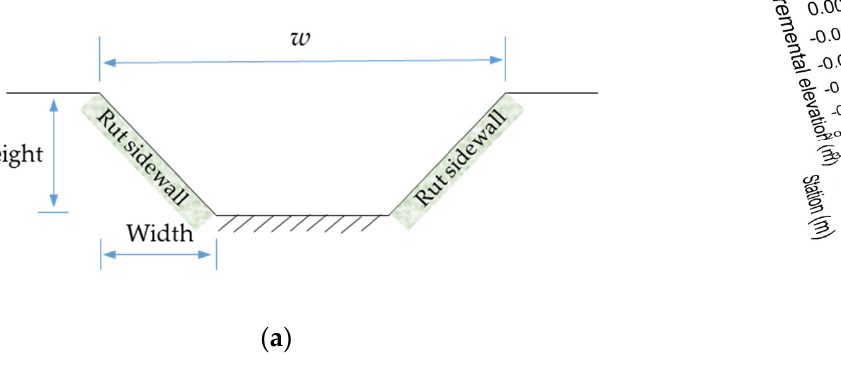
Figure 6. Schematic view of Rutting model: ( a ) Simplified trapezoid rutting shape; ( b ) rutting model in Carsim software (in case of WHR = 10).